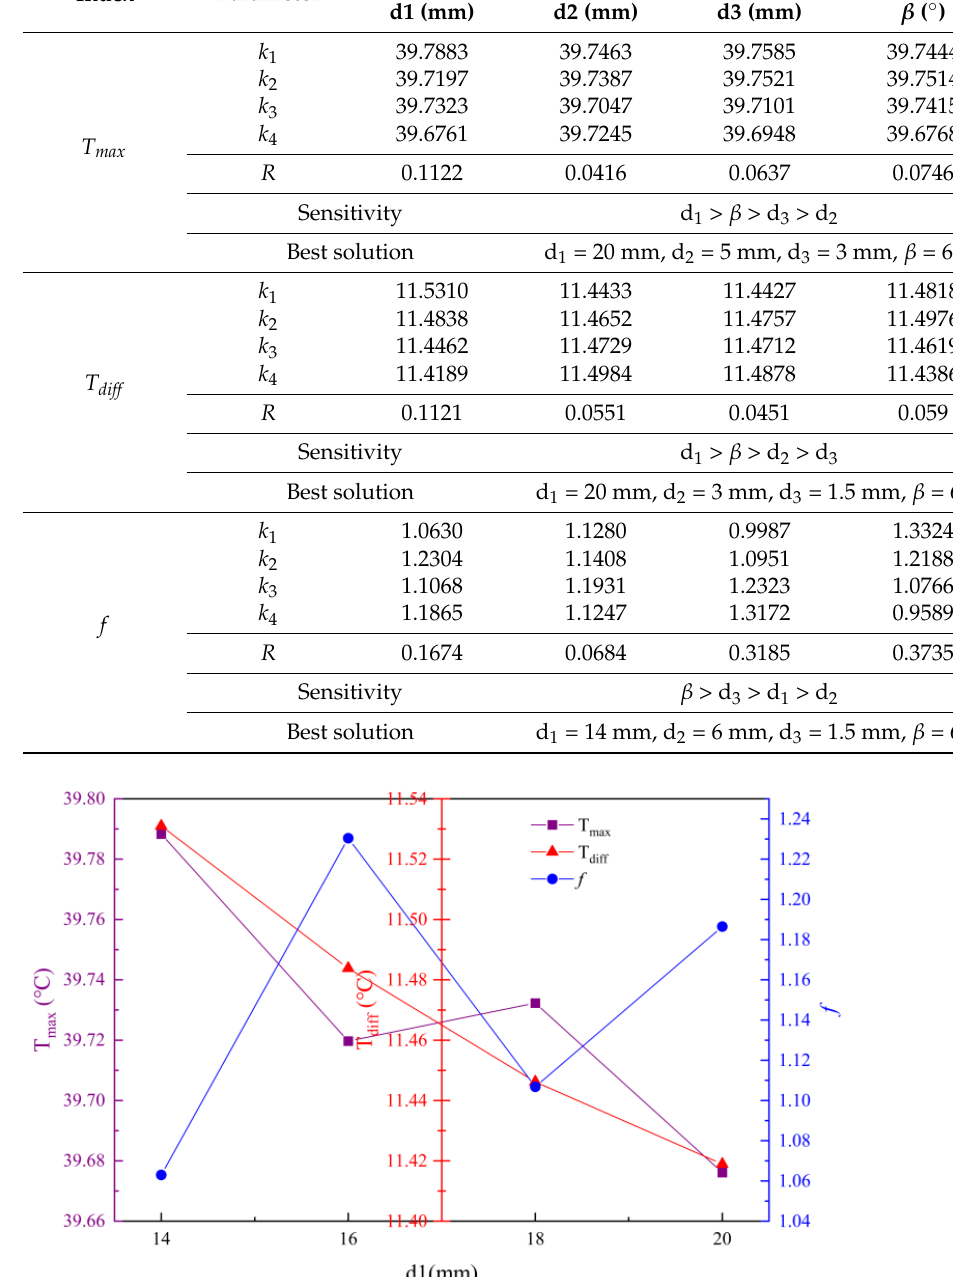
1 on evaluation